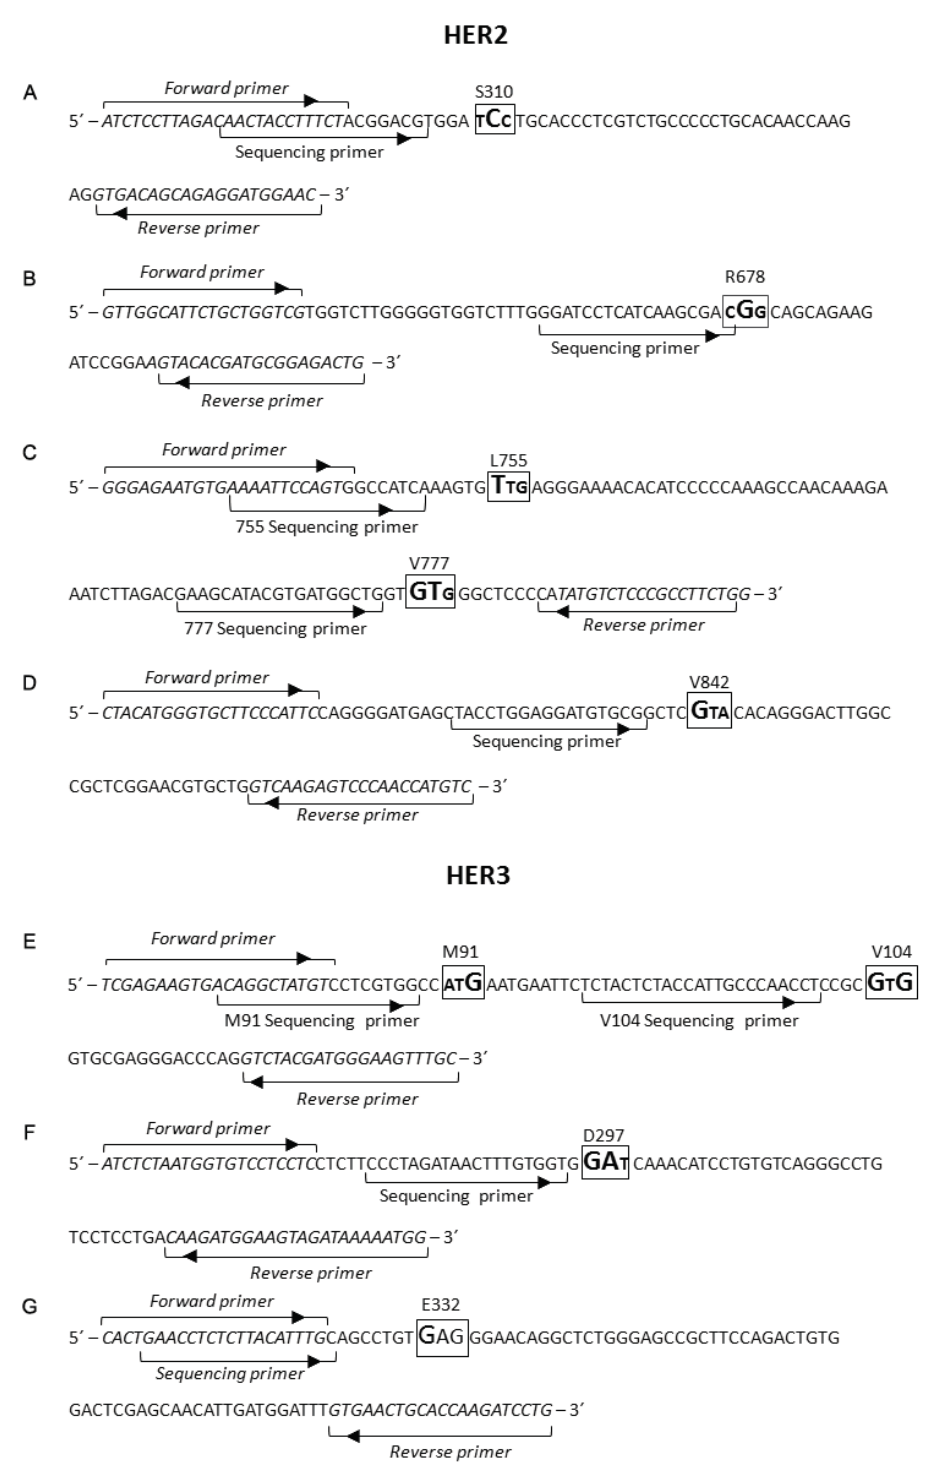
Figure 2. Pyrosequencing assay maps. These show PCR sequence and target mutations, as well as primer designs for PCR amplification and pyrosequencing for HER2 and HER3 mutation analysis. Arrows indicate the specific hybridization site for both PCR and sequencing primers, and the 5 ′ to 3 ′ direction for DNA-polymerase amplification. All reverse primers for PCR amplification are 5 ′ -biotinylated. ( A – D ) Primer designs for HER2 assays ( A ) S310, ( B ) R678, ( C ) L755 and V777, ( D ) V842; ( E – G ) Primer designs for HER3 assays ( E ) M91 and V104, ( F ) D297, and ( G )